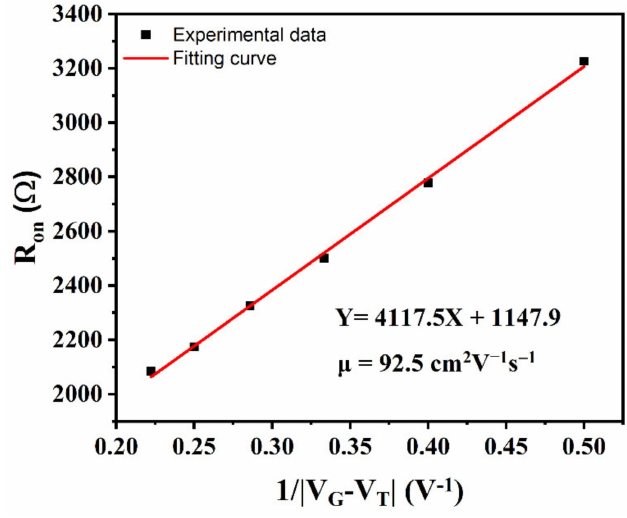
Figure 6. The plot of R on versus 1/(V G − V T ) and fitting